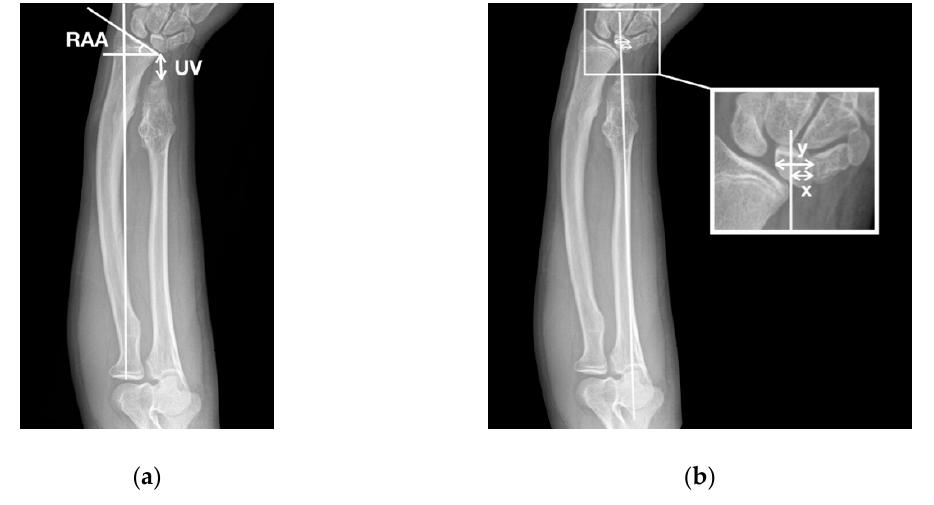
Figure 2. Radiographic parameters. ( a ) Ulnar variance (UV): the distance between the distal ulnar epiphysis and the ulnar side of the distal radial epiphysis. Radial articular angle (RAA): the angle defined between a line along the radial articular surface and a line perpendicular to the line drawn from the center of the radial head to the radial border of the distal radius. The normal value is 15–30°; ( b ) carpal slip (CS): the percentage of the lunate that falls on the ulnar side, with a reference line drawn from middle of the olecranon to the ulnar border of the radial epiphysis ( x / y × 100%). The normal value is 50%.